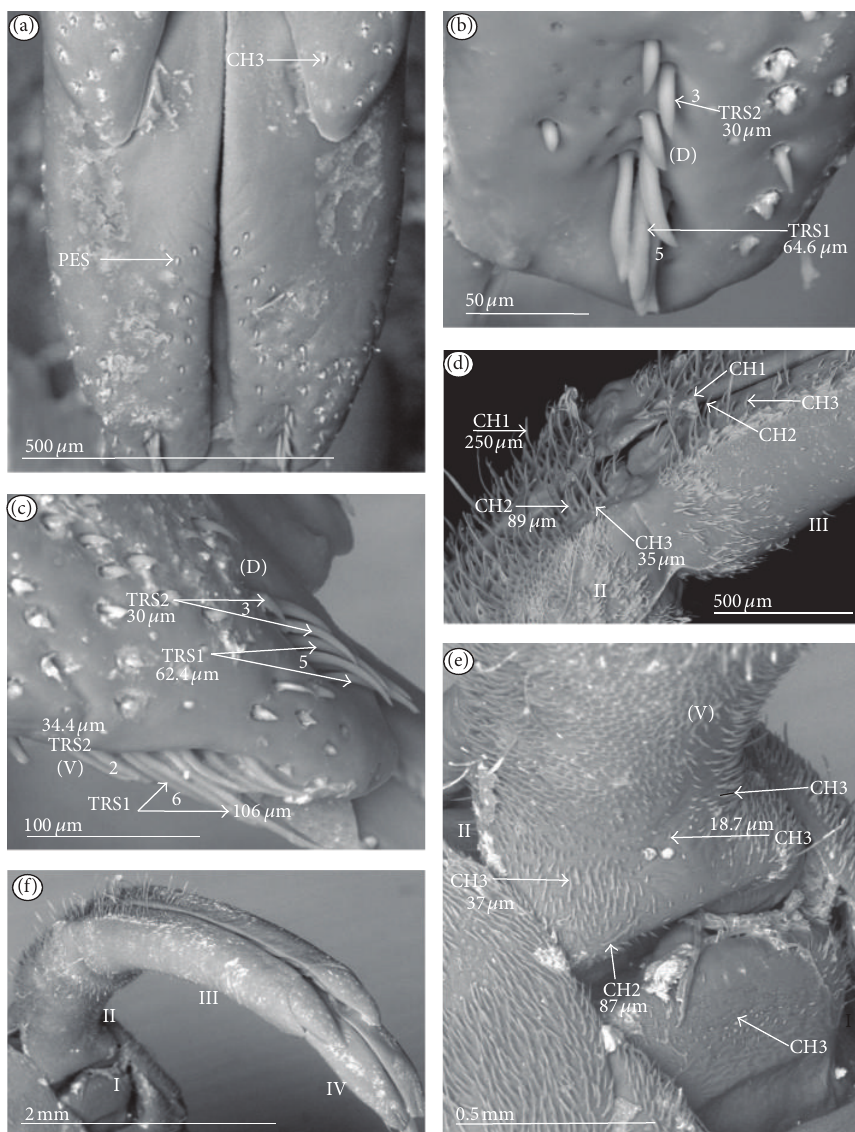
Figure 13: Types, sizes, and distribution of the sensilla of the Belostomatinae ( Limnogeton fieberi ). (a) PES are specifically situated only in the small area near the apex. (b) TRS2 (three), TRS1 (five) form a single row and are placed dorsally (D) near the apex of the labium. (c) TRS2 (two), TRS1 (six) form a single row and are placed ventrally (V) near the apex of the labium. (d) CH1, CH2, and CH3 densely cover the dorsal surface of the labium on segments II and III. (e) CH3 are numerous and is cover all surface of the ventral side of segment II, one pair of CH2 and at the base of the second segment, CH3 are densely distributed over segment I (ventrally). (f) Total view on the labial segments showing type (A) distribution of the labial